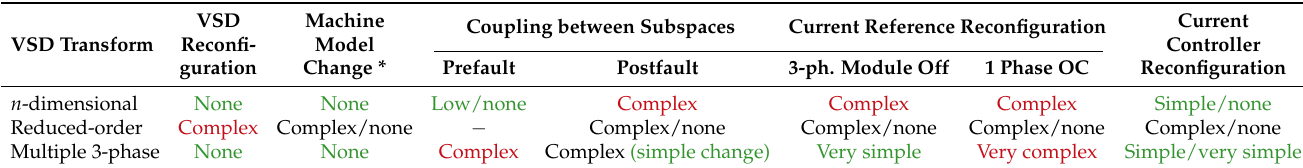
Table 4. VSD approaches for drives tolerant to phase OCs (Section 3.1) in multiphase applications in the